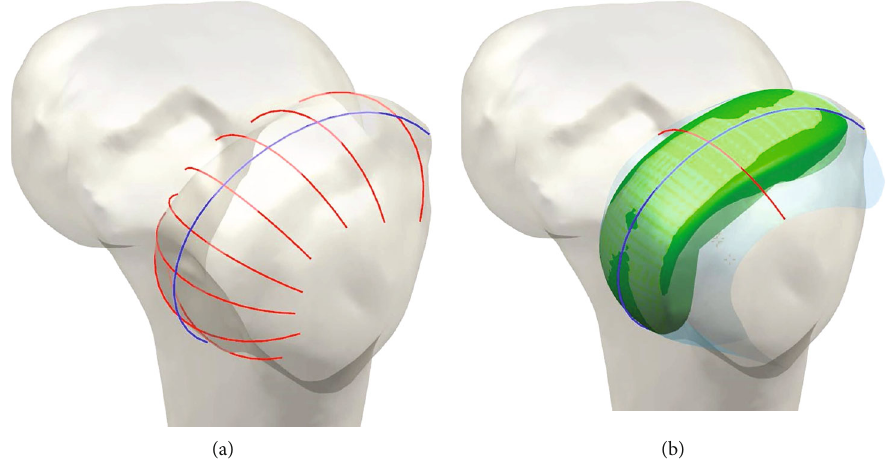
Figure 1: (a) Intersection curves were used to extract the articulating surface geometry in the sagittal and coronal planes and (b) in the development of the femoral component of the patient-speci fi c UKA using sagittal curves and constant coronal curves.